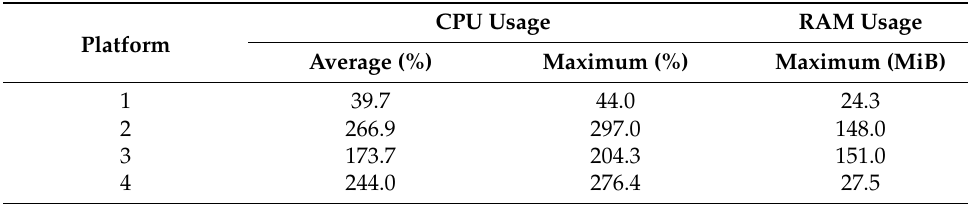
Table 11. CPU and RAM usage summary.